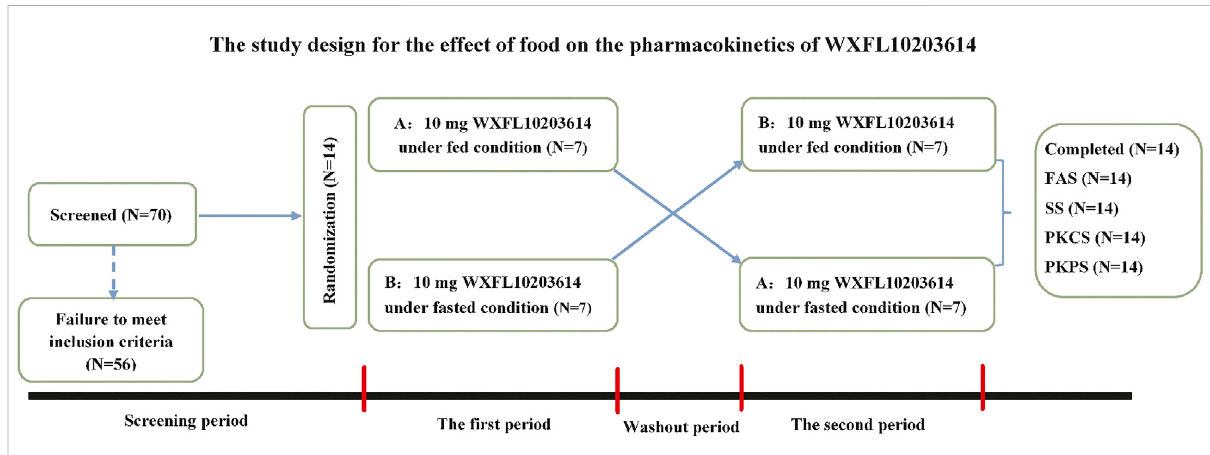
FIGURE 1 The study design for the effect of food on the pharmacokinetics of WXFL10203614. FAS, The Full Analysis Set; SS, Safety set; PKCS, Pharmacokinetic concentration set; PKPS, Pharmacokinetic parameter